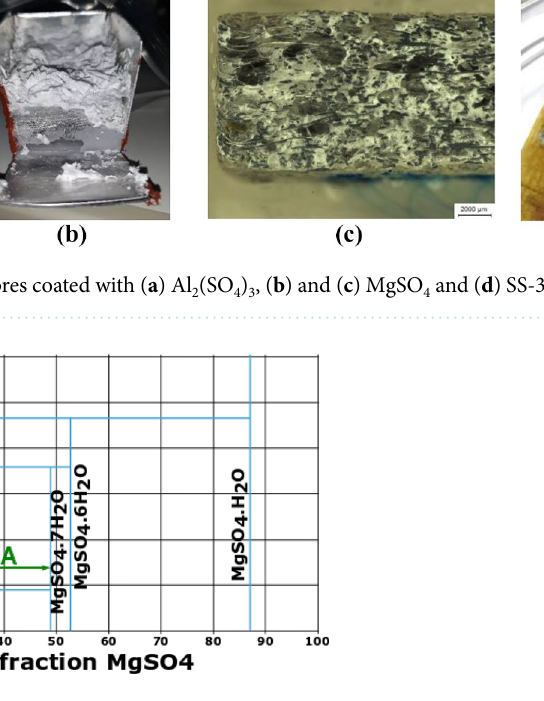
Figure 13. Schematic representation of the crystallization method by cooling and separation of solid and liquid phases with MgSO 4